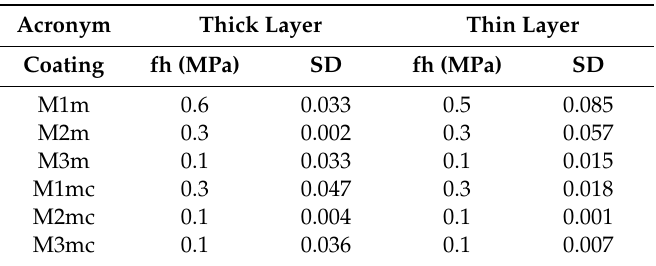
Table 2. Pull-o ff results of the coatings for the examined thick and thin layers, with the respective standard deviation (SD) values